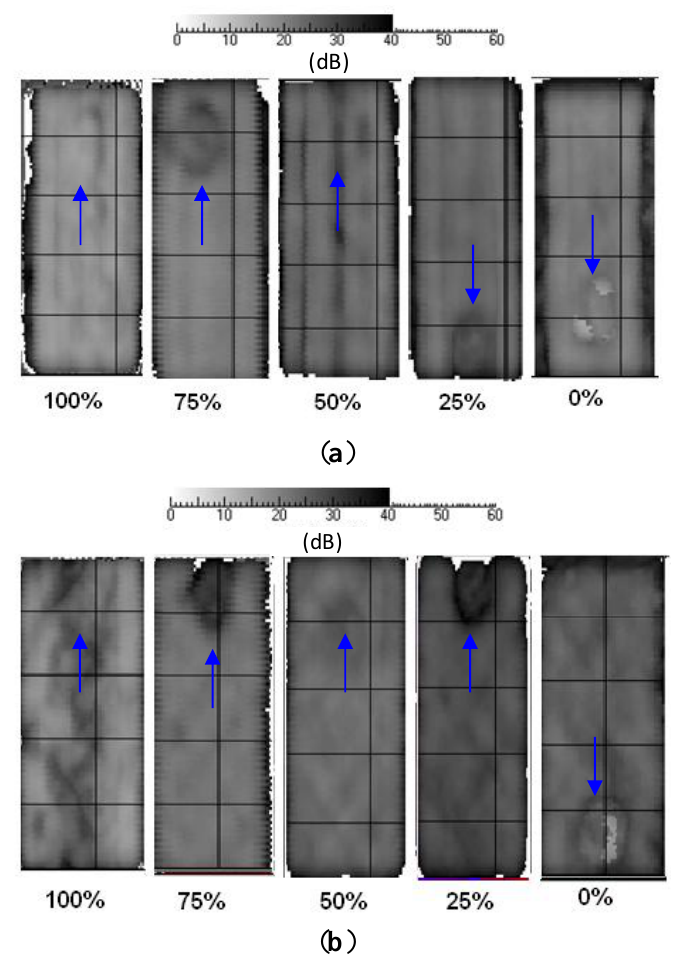
values. ( a ) Pu coupons; ( b ) Ps coupons. An c